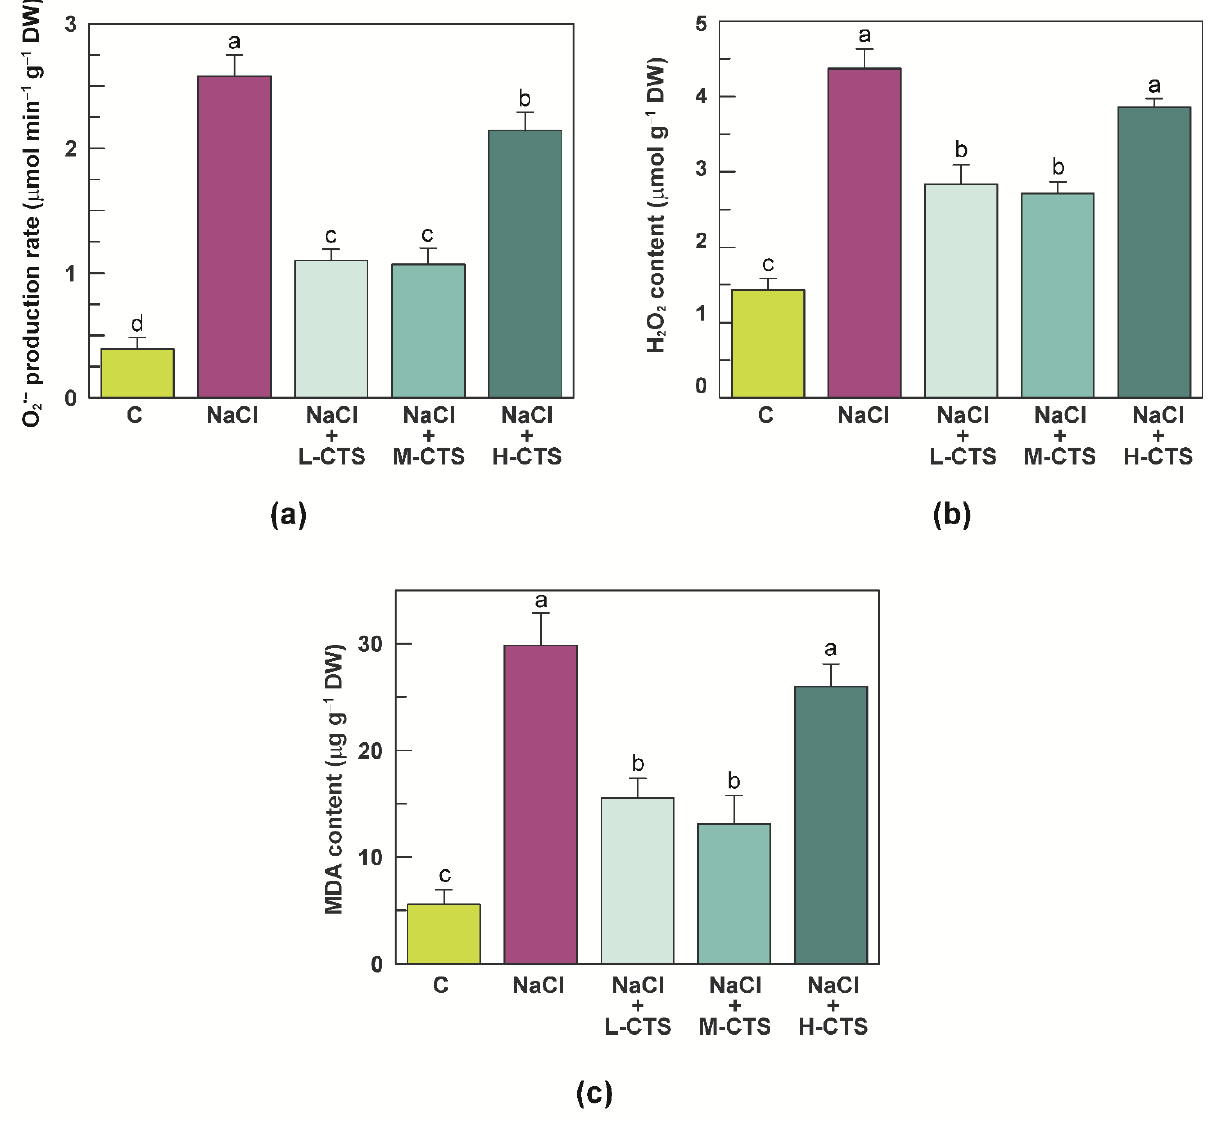
Figure 1. ( a ) Superoxide anion (O 2• − ) production, ( b ) hydrogen peroxide (H 2 O 2 ) and ( c ) malondialdehyde (MDA) content in the shoot of durum wheat seedlings grown under control, NaCl stress and NaCl stress + CTS treatment. Vertical bars represent S.D. ( n = 3). Different letters indicate significant differences according to the Tukey’s test ( p ≤ 0.05).